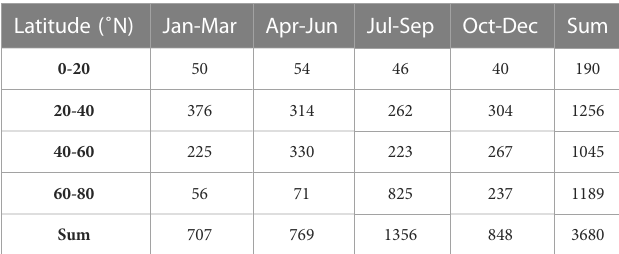
TABLE 1 Temporal and spatial coverage of the BGC-Argo data set used for calculating PP including pro fi les with nitrate and chlorophyll measurements and associated satellite observations of surface PAR from the North Atlantic, Mediterranean and subpolar seas in the period 2011- 2022.